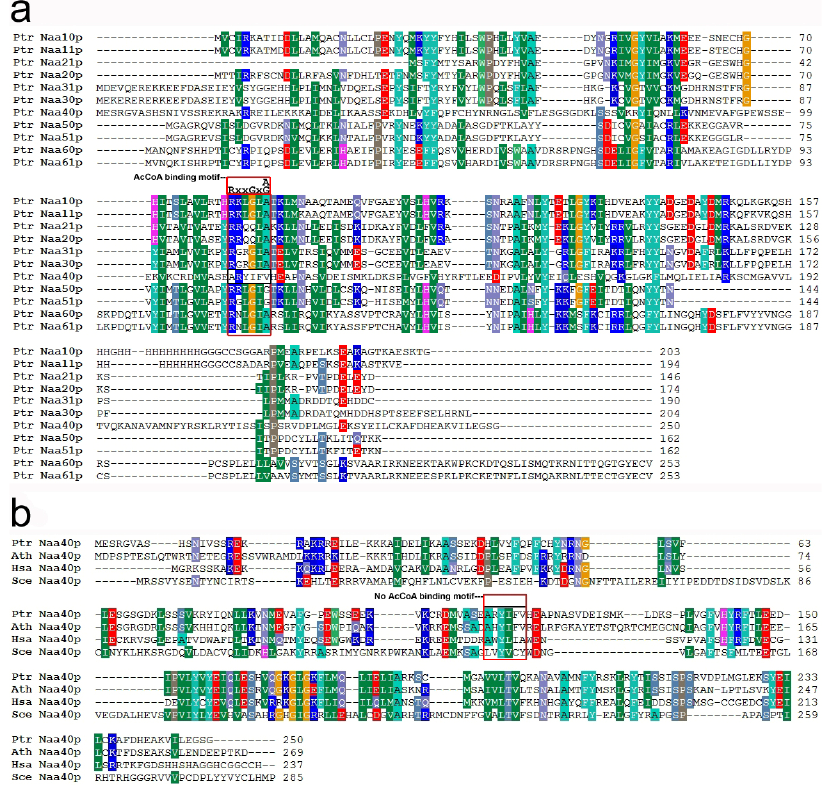
Figure 3. Amino acid sequence alignment. ( a ) Amino acid sequence alignment of all predicted Nat CS from poplar; ( b ) Amino acid sequence alignment of poplar NatD catalytic (Ptr Naa40p) subunit with its counterparts from Arabidopsis , yeast and humans. Gaps are introduced to ensure maximum identity. Color shading represents 70% identical residues among the sequences. The consensus acetyl coenzyme A (AcCoA) binding motif sequence RxxGxG/A, where x can be any amino acid, is boxed (red). The identifiers of the Nat CS proteins from poplar are shown in Table 1. Ath Naa40p